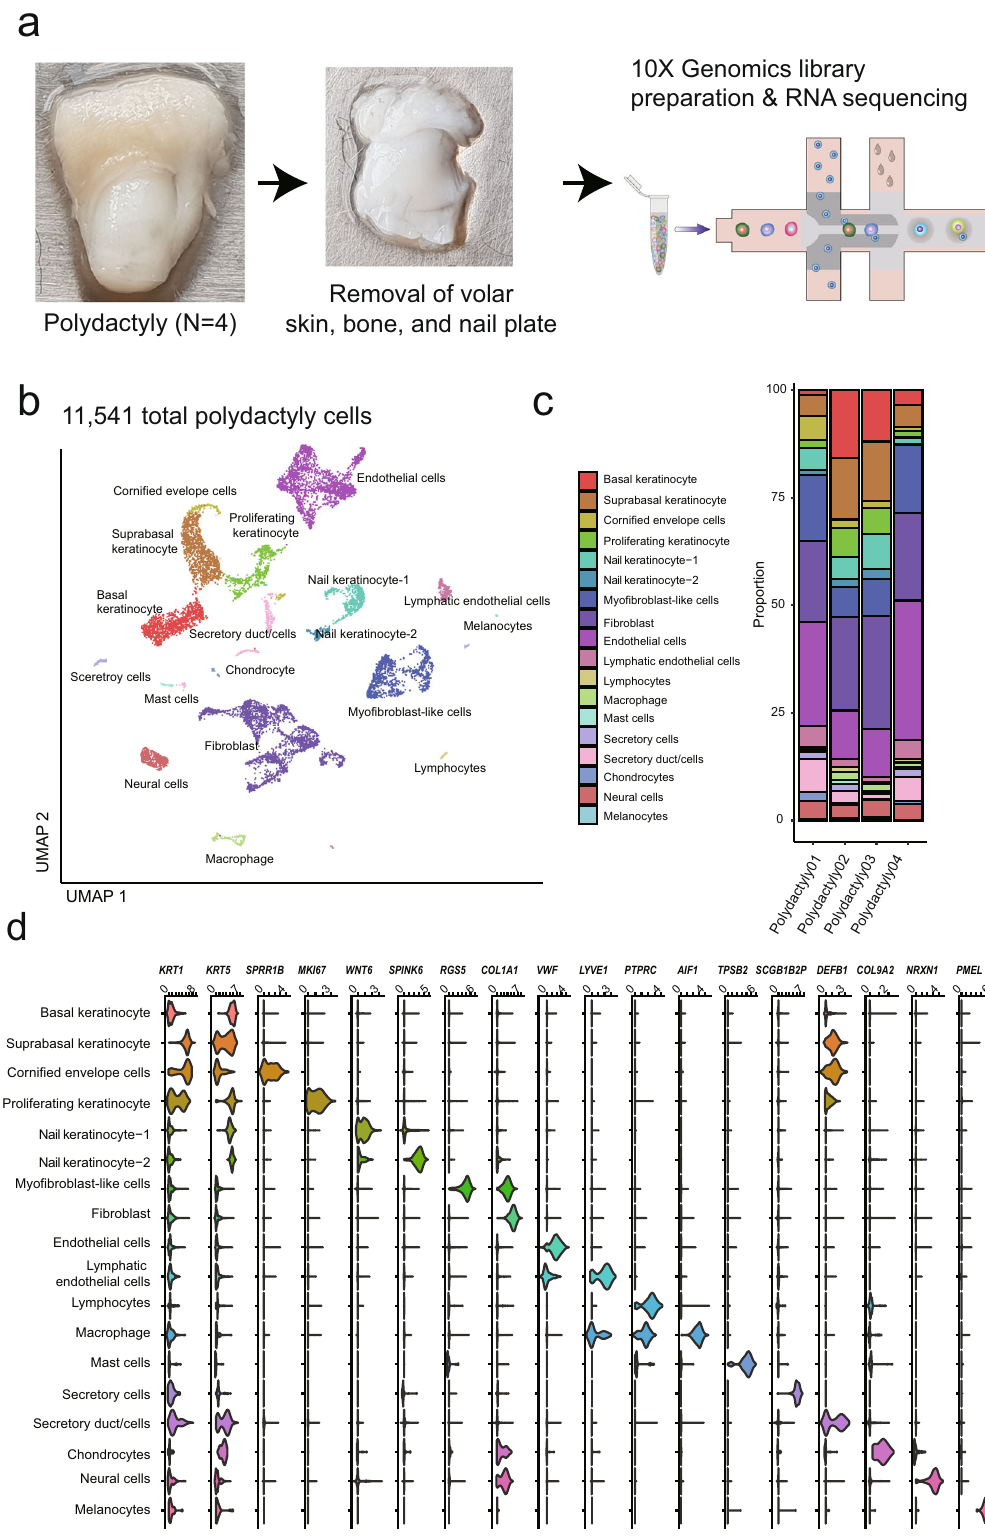
Fig. 1 scRNAseq of human nail unit reveals conserved cell populations. a An overview. Four extra-digits were dissociated into the single-cell suspension ( n = 11,541 cells). b A UMAP plot demonstrated 18 clusters. c Relative proportions of each cell-type color-coded by cell-type and annotated for clusters as in Fig. 1b. d Cluster annotation. The violin plot represents an expression of canonical markers of each